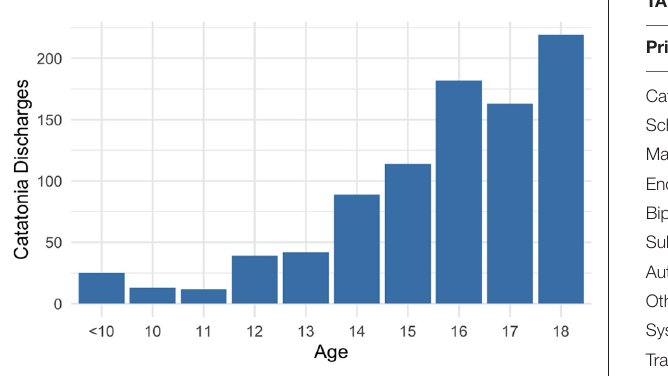
FIGURE 1 | Age distribution of patients diagnosed with catatonia.